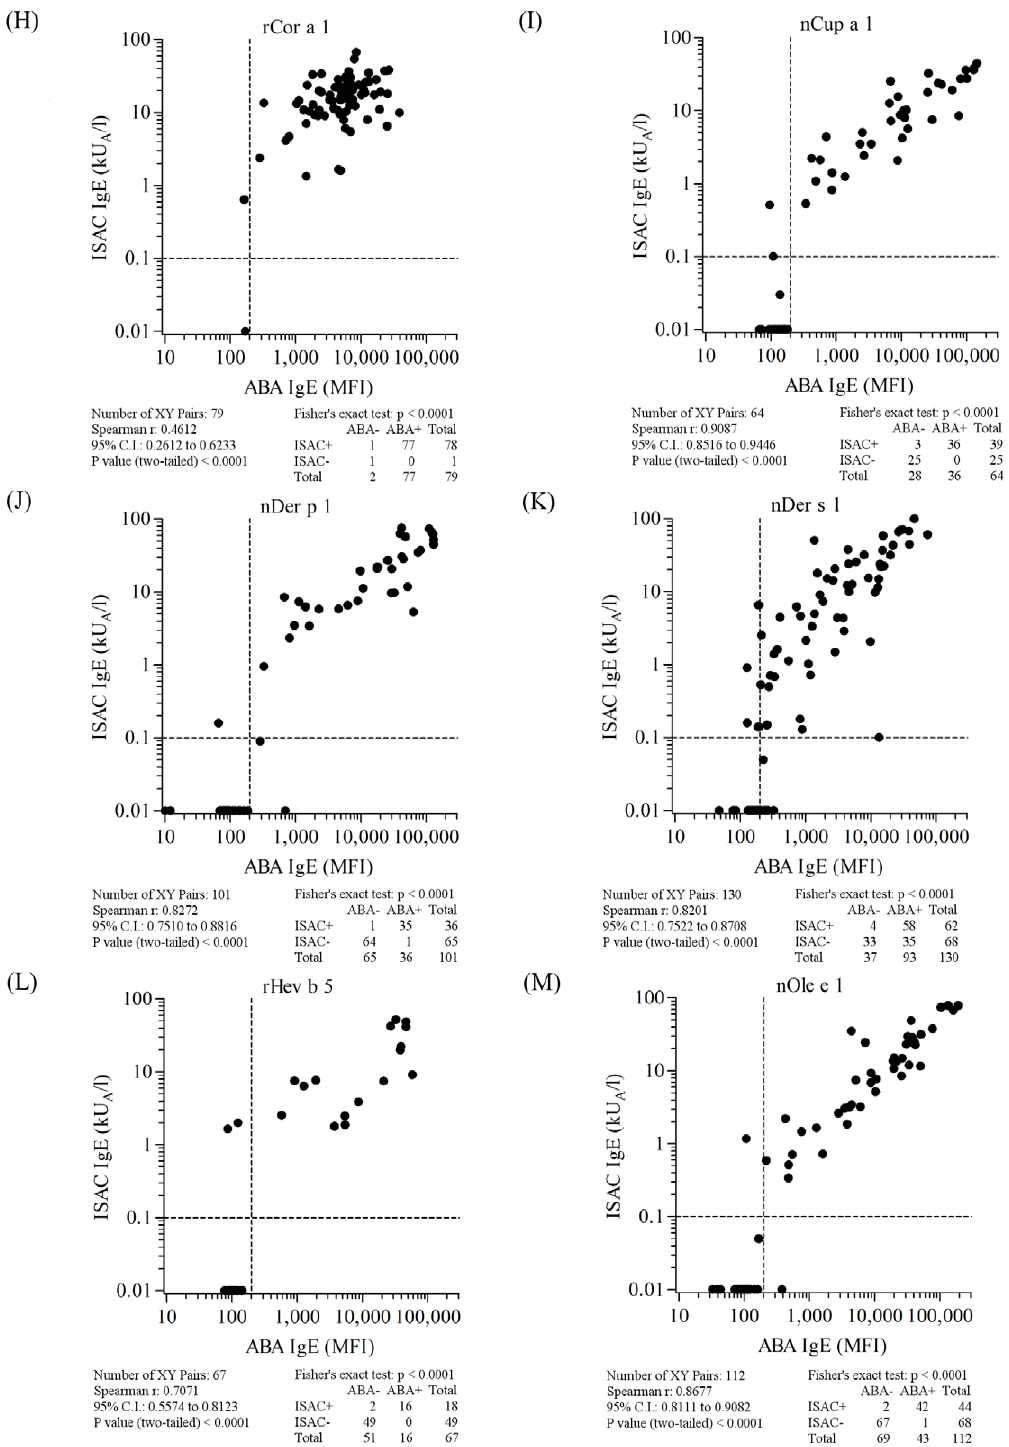
Figure 7. ABA versus ISAC correlation results on serum samples selected on the basis of the allergen specificities reported in each panel and listed in Table S1. Letter flags, namely H, I, J, K, L, M, in figure 7 indicate them as parts of the results shown also in figures 5, 6, and 8. Consecutive letters are used on purpose to recall result type continuity across the four figures. Allergen nature, being either natural or recombinant, matched for both tests. Vertical dashed lines represent the arbitrary ABA negative cut off value. Horizontal dashed lines mark the value range where ISAC IgE determinations are not always reproducible (unpublished data). For graphical visualization needs on log scales, zero value for ABA was set at 10 MFI on the X axis, and at 0.01 kU/l for ISAC value on the Y axis. The Spearman r correlation coefficient was calculated and the Fisher’s exact test was used for statistical purposes. Statistical results are reported below each graph.